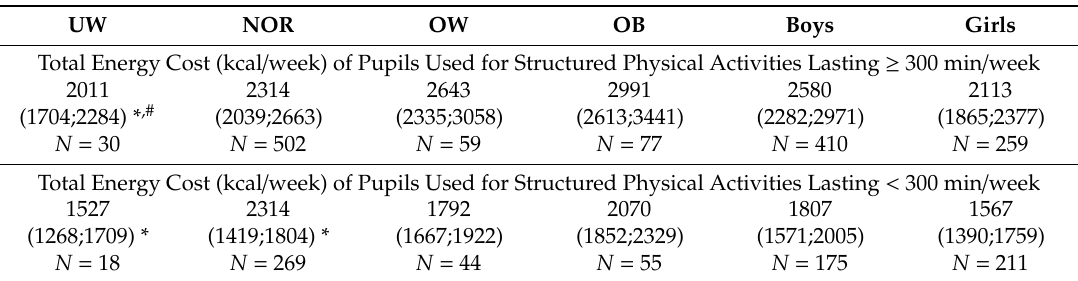
Table 6. Total energy costs of the study groups and by sex.